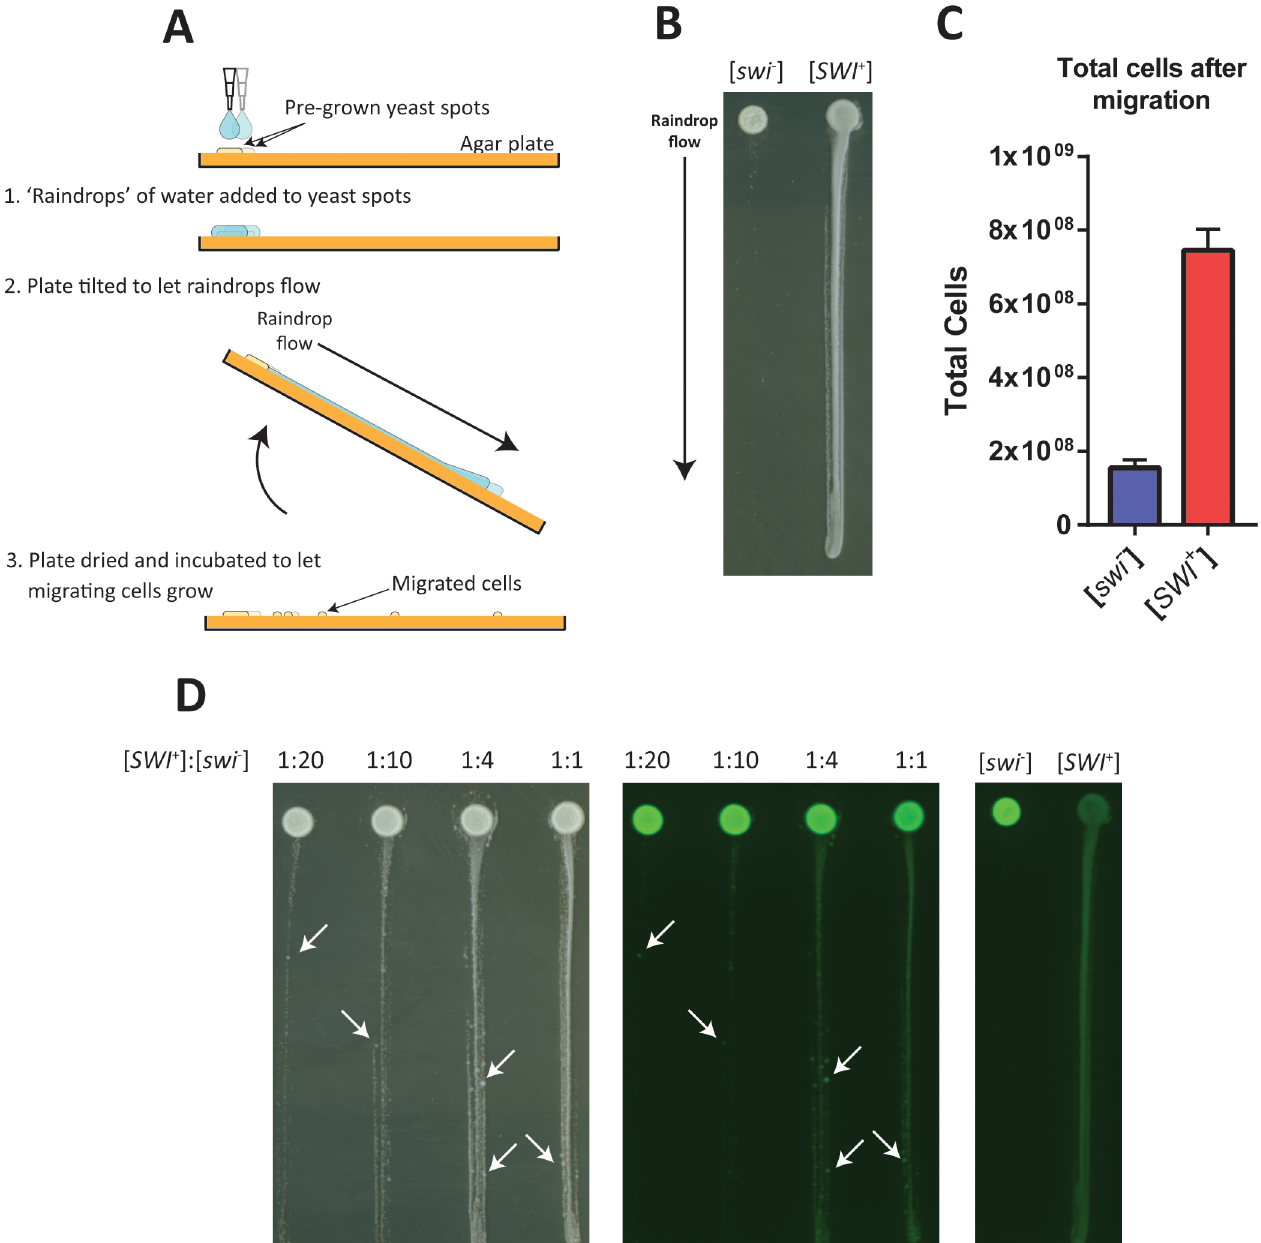
Fig 1. The [ SWI + ] prion enhances the migration of cells with the flow of water. (A) A diagram of the experimental procedures used to test the migration of cells on solid media. Pregrown spots of yeast coloniesexperience “rainfall”as drops of water are pipetted over them. The plates are tilted to allow the water to flow across the surface. After drying and incubating for yeast growth, coloniesestablished by the migrated cells appear. (B) Photographshowingthe migration of [ swi − ] and [ SWI + ] cells on an agar plate. (C) Quantification of total cell numberafter the migration experiment. Error bars indicate standarddeviation( n = 3). Numericaldata are available from the Dryad DigitalRepository: http://dx.doi.org/10. 5061/dryad.d5r16.(D) Left: Photographshowingthe migration of cells on an agar plate after [ SWI + ] and [ swi − ] cells were mixed in the indicated proportions. Arrows indicatelarge colonieswhere small flocs of [ swi − ] cells have migrated. Center: The same image collectedin a green fluorescence channel. Due to the yTRAP sensor [15] in both strains, [ swi − ] coloniesare brightly fluorescent. Right: Migration experimentfrom panel B photographed in the green fluorescence channelfor comparison. yTRAP, yeast transcriptional reportingof aggregating proteins.